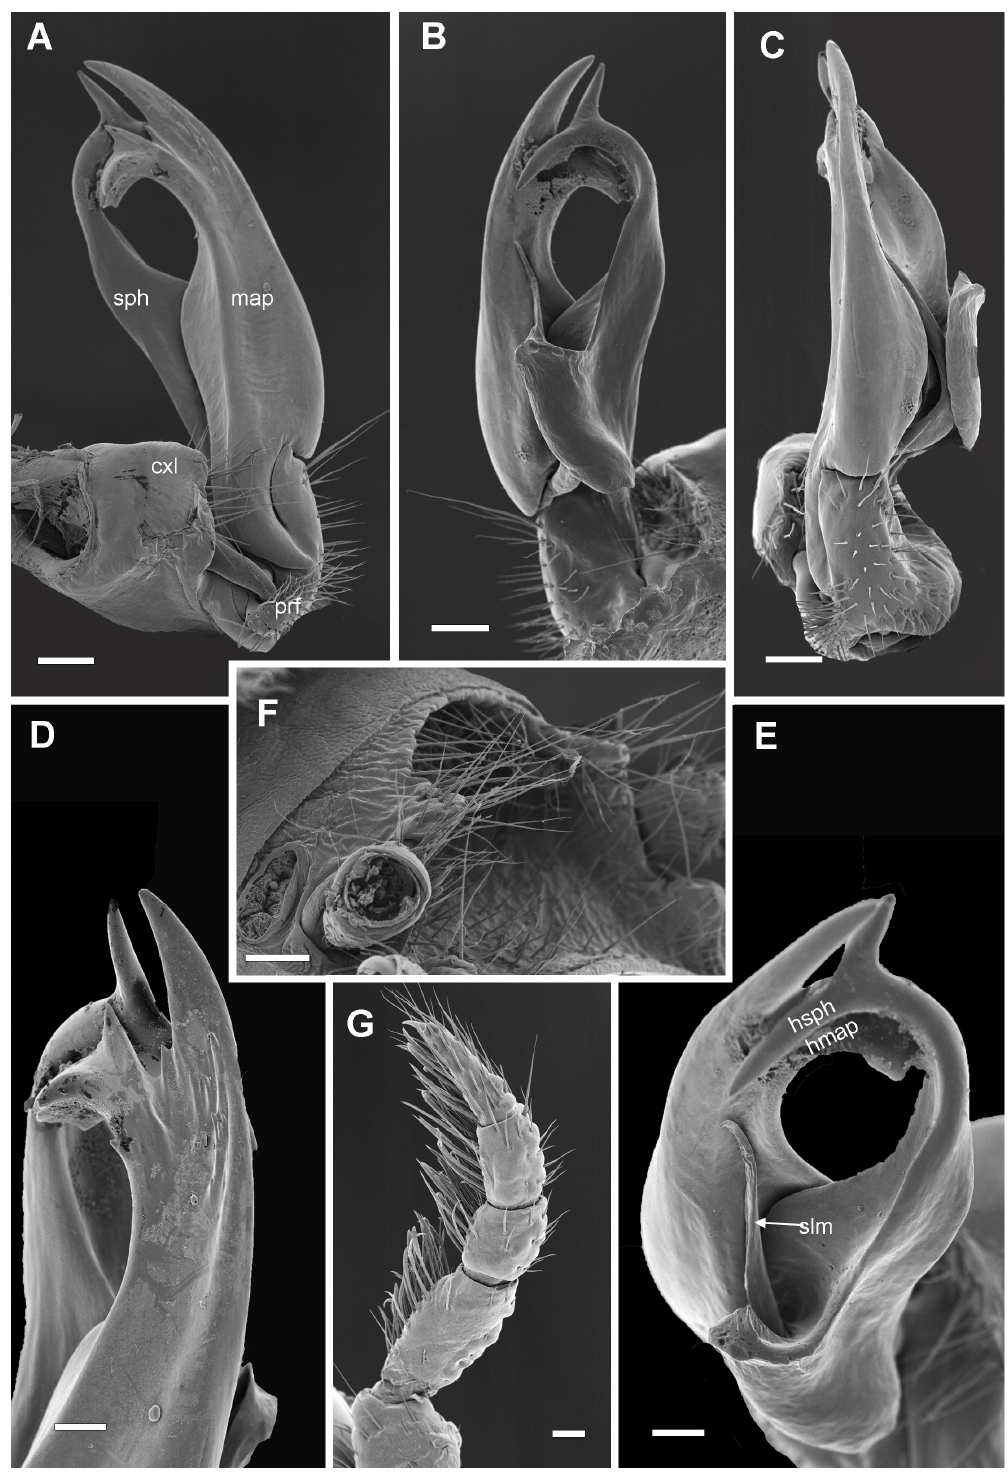
Fig. 34. Eviulisoma angulatum sp. nov., paratype. A–E . Left gonopod. A. Mesal view. B. Lateral view. C. Ventral view. D. Tips of mesal acropodital process and solenophore, mesal view. E. As D, latero-dorsal view, also showing solenomere. F . Excavation of sternum 6. G . Leg from ring 6. Abbreviations: cxl = coxal lobe; hmap = hook-shaped process of map ; hsph = hook-shaped process of sph ; prf = prefemoral part; slm = solenomere; sph = solenophore. Scale bars: A–C, F = 0.1 mm; D–E, G = 0.05